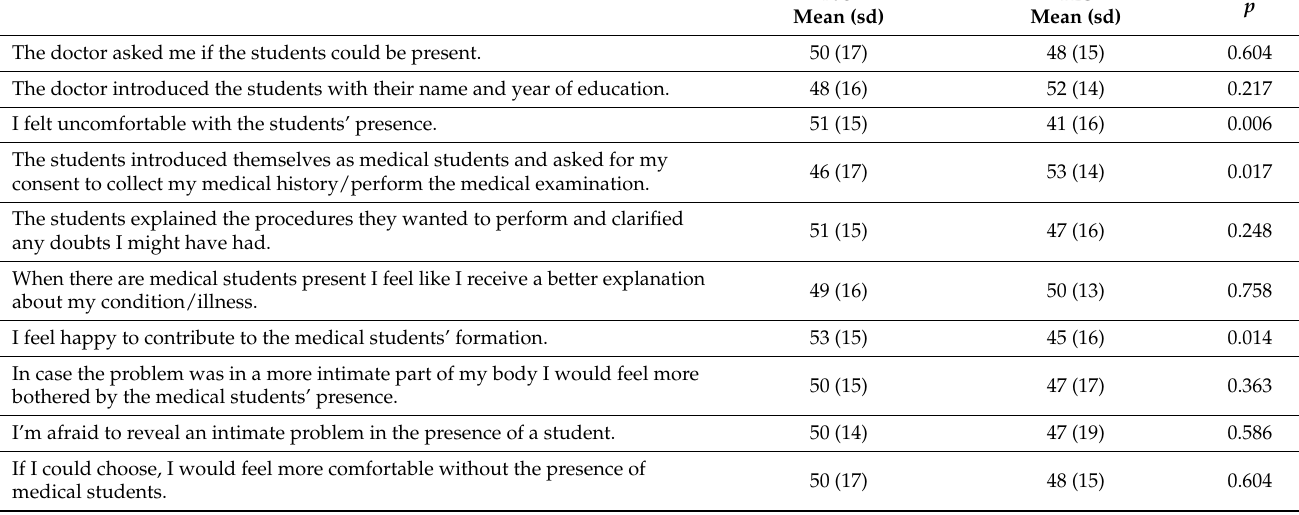
Table 4. Mean (standard deviation) of the age of the inquired patients who answered affirmatively or negatively to the questions about the presence of medical students on a previous consultation and/or hospital